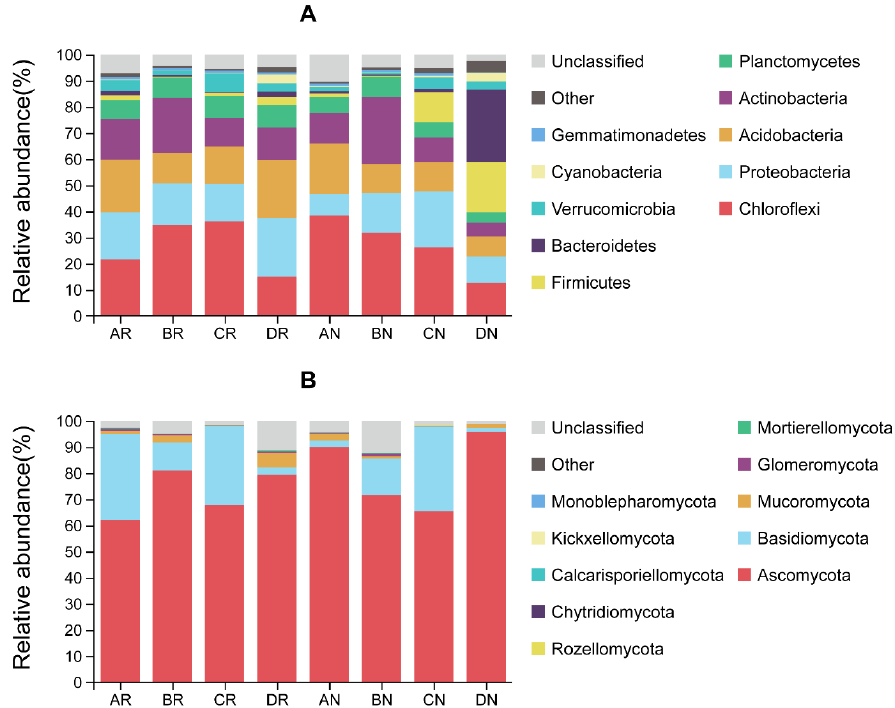
Figure 1. Relative abundance of bacteria ( A ) and fungi ( B ) at the phylum level. AR, BR, CR, and DR indicates rhizosphere soil sample in spring, summer, autumn, and winter, respectively. AN, BN, CN, and DN indicates non-rhizosphere soil sample in spring, summer, autumn, and winter, respectively. n = 3.